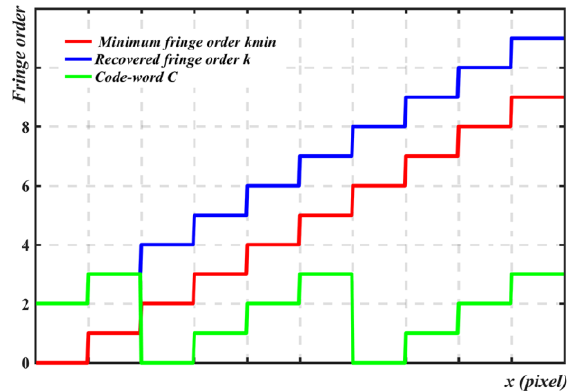
Figure 5. Fringe order determination using the minimum fringe order k min .